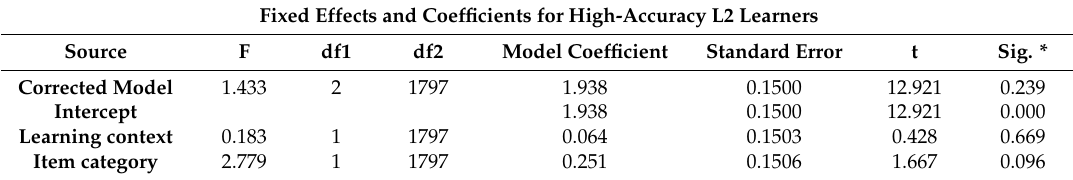
Table 6. Overview of main effects from binomial logistic regression in high-accuracy L2 learners.